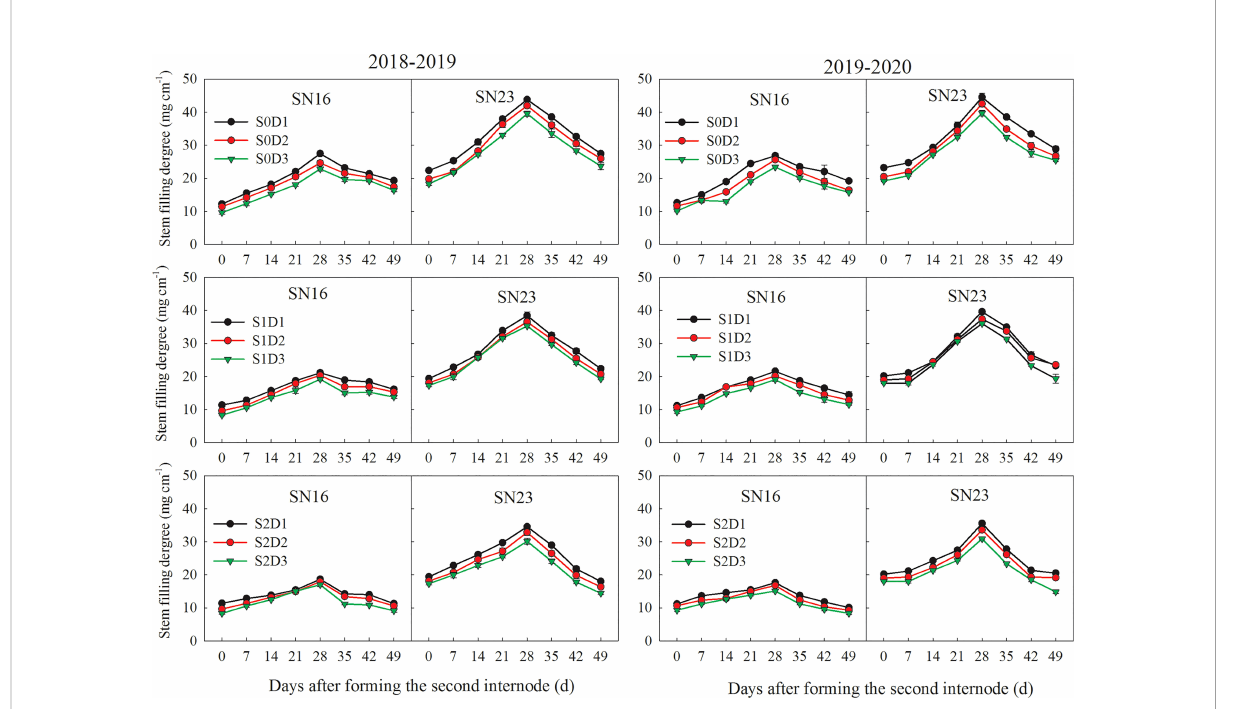
FIGURE 2 Effects of shading on fi lling degree of the second basal internode of wheat under different planting densities. Error bars represent the standard deviation of the mean (n =